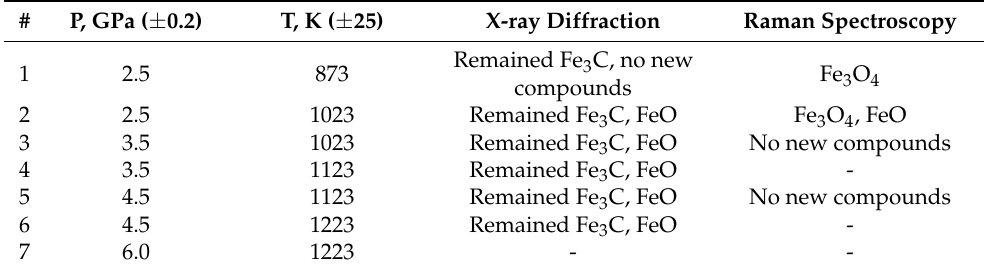
Figure 2. Pie charts of hydrocarbon products, formed from the chemical reaction of iron carbide and water. Blue sectors— CH 4 , orange sectors—C 2 H 6 , grey sectors—total amount of heavier hydrocarbons C 3+ . The results of the solid product analysis are presented in Table 2. Table 2. Results of the Analysis of the Solid Products Formed from Fe 3 C and H 2